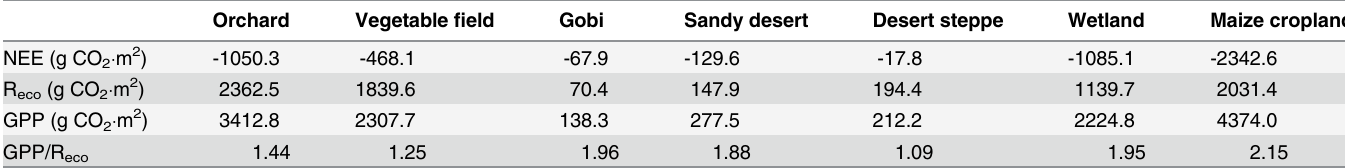
Table 2. Total GPP , R eco , and NEE for different ecosystems during the observation period (June 10 — September 14, and, in wetland, June 26 — Sep- tember 14)